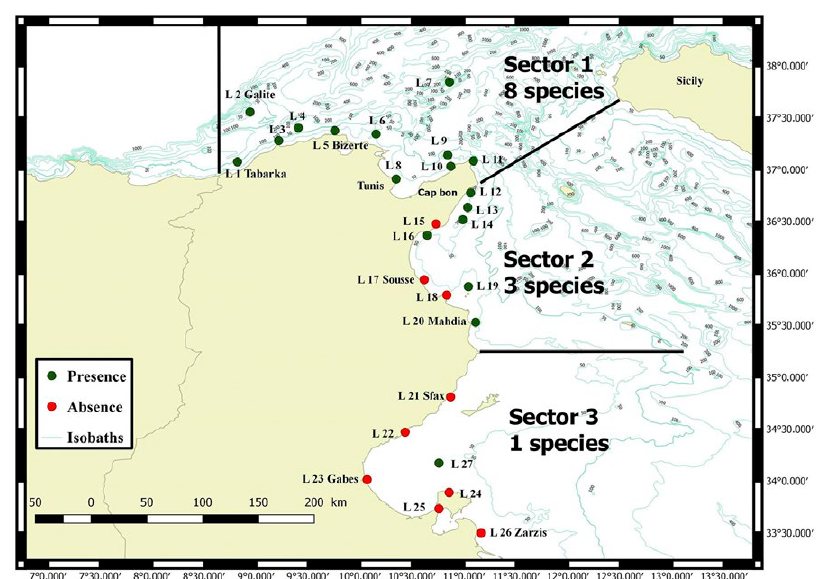
Fig. 2. – Presence and absence of gorgonian species in sectors and localities investigated in Tunisian marine